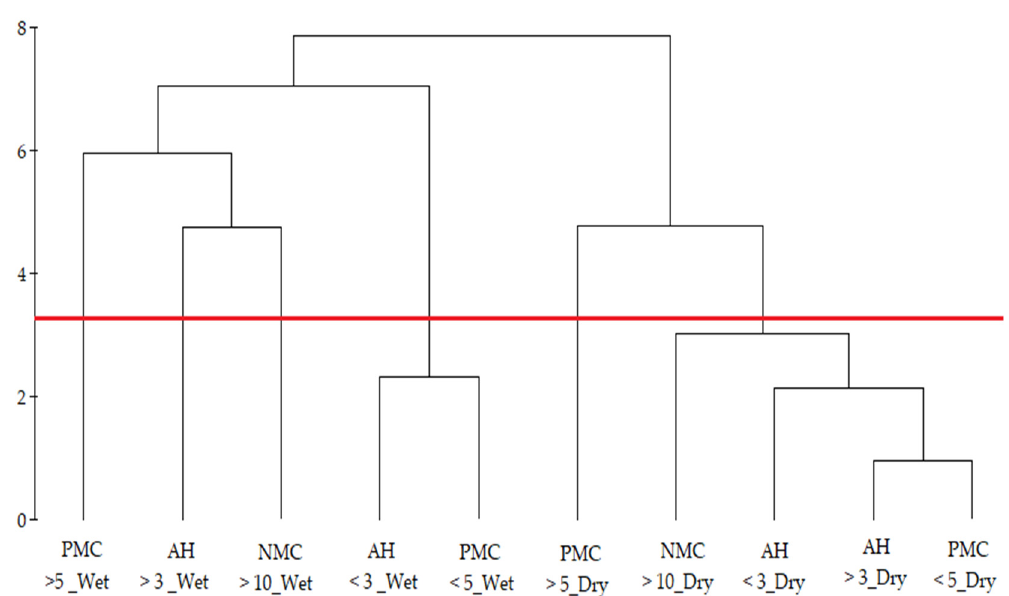
Figure 3. Water quality classification at the locations on deep acid sulfate soils.